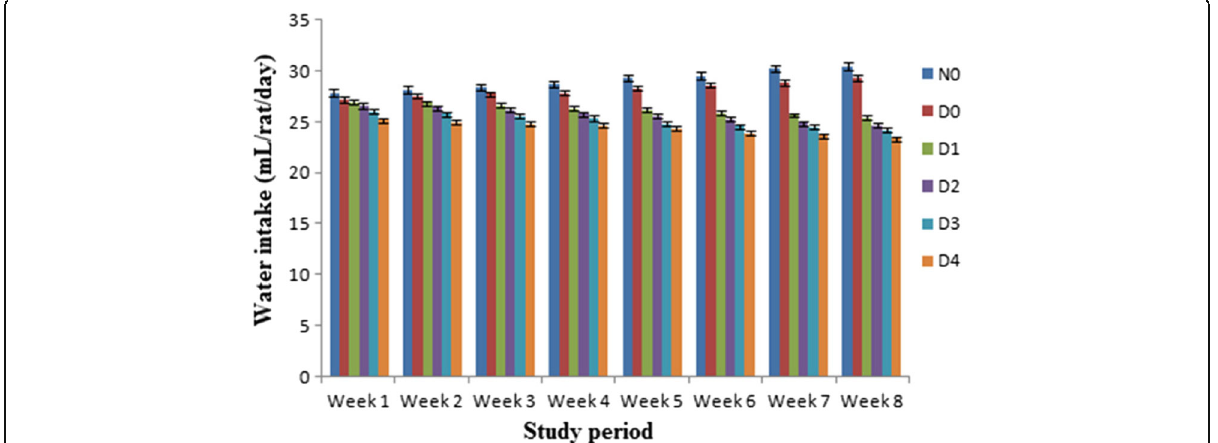
Fig. 2 Water intake (mL) in normal and diabetic rats during 8 weeks (rat/week). Results are expressed as amount of water intake levels of diabetic and non-diabetic rats (mean ± standard deviation (SD). n = 10). The water intake of diabetic rats (D 1 , D 2 , D 3 and D 4 ) received stevia aqueous extract in different concentrations (200, 300, 400 and 500 ppm) respectively significantly (P < 0.05) decreased from non-diabetic (N 0 ) and diabetic (D 0 ) control